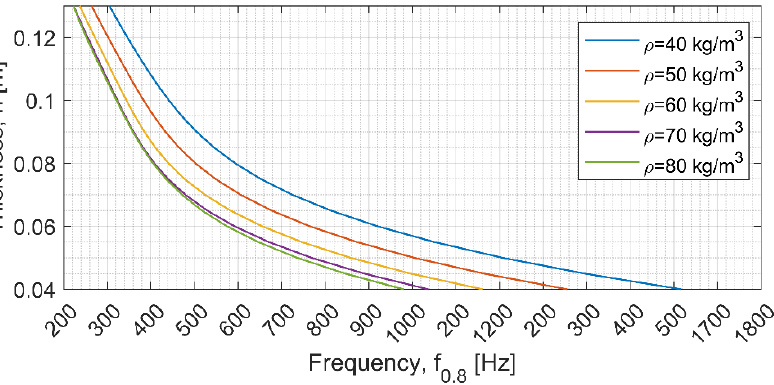
( c ) Figure 10. Calculated sound absorption coefficients for RPU foams with different thicknesses. In order to estimate the frequency after which the sound absorption coefficient be- came larger than 0.8, f 0.8 , for a given thickness [m] and density [kg/m 3 ] of the RPUF, a polynomial surface model with x degree of 4 and y degree of 2 was fitted to the predicted data for a range of thicknesses h = 0.04–0.13 m and considered densities ρ = 40 kg/m 3 , ρ =